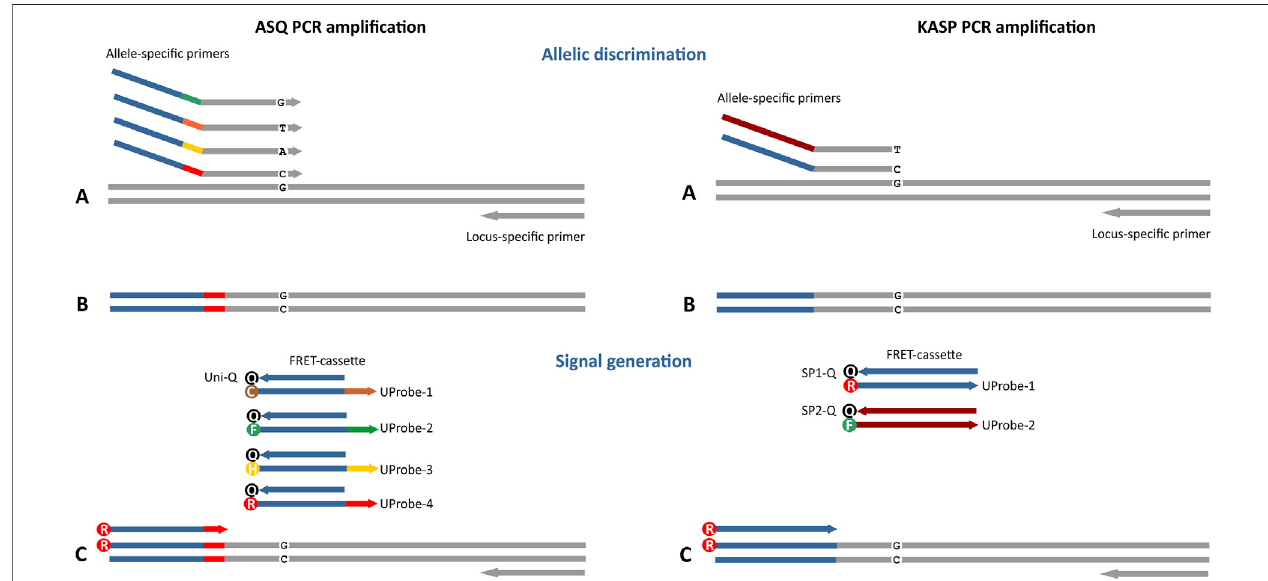
FIGURE 1 | Four-plex fl uorescent ASQ assay genotyping system compared to the standard two-plex KASP technology (LGC Biosearch Technologies). The main differences in these approaches are associated with the potential number of simultaneously detectable polymorphic sites (4 in ASQ, 2 in KASP) and the structure of the primers that compose the FRET cassette. For ASQ, the FRET cassette consists of 2 or more of allele-speci fi c primers (ASP) and a fl uorescently labelled universal probe (UP) with a single universal quencher probe (Uni-Q). Differences in the tail sequence ASPs and UPs are determined by a unique 6-nt barcode sequence that is not part of the universal tail of the Uni-Q sequence. KASP technology includes 2 variants of ASPs and fl uorescently labelled UPs (UP-1/2) with each UP requiring a speci fi c quencher(SP1/2-Q).Inaddition,theabilitytodesignanallele-speci fi cprimerwiththeSNPsiteatthepenultimateorantepenultimate3 ′ baseofeachallele-speci fi cprimer is characteristic of the ASQ method. (A) Both allele-speci fi c primers query the SNP locus. Denaturation of DNA template and annealing ASP to the target, PCR round 1. (B) Formation of a PCR product containing a speci fi c tail sequence that is complementary to allele-speci fi c primers. This PCR product will be used in subsequent PCR cycles as a template for ampli fi cation using a speci fi c fl uorescently labelled UP (C) . During the fi rst two ampli fi cation cycles, a tail sequence is incorporated into the amplicon that is subsequently recognized by a universal, probe-based reporter